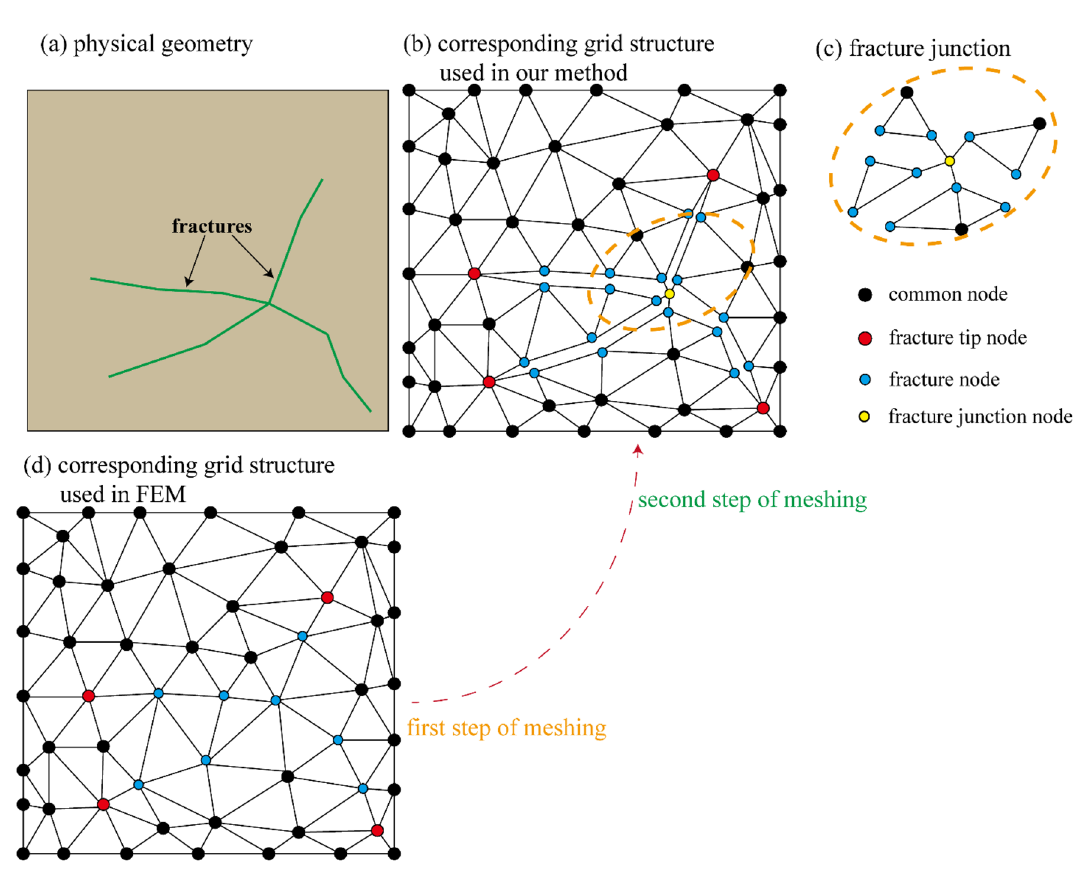
Fig. 4 Two-dimensional illustration of the grid structure (Wei et al.